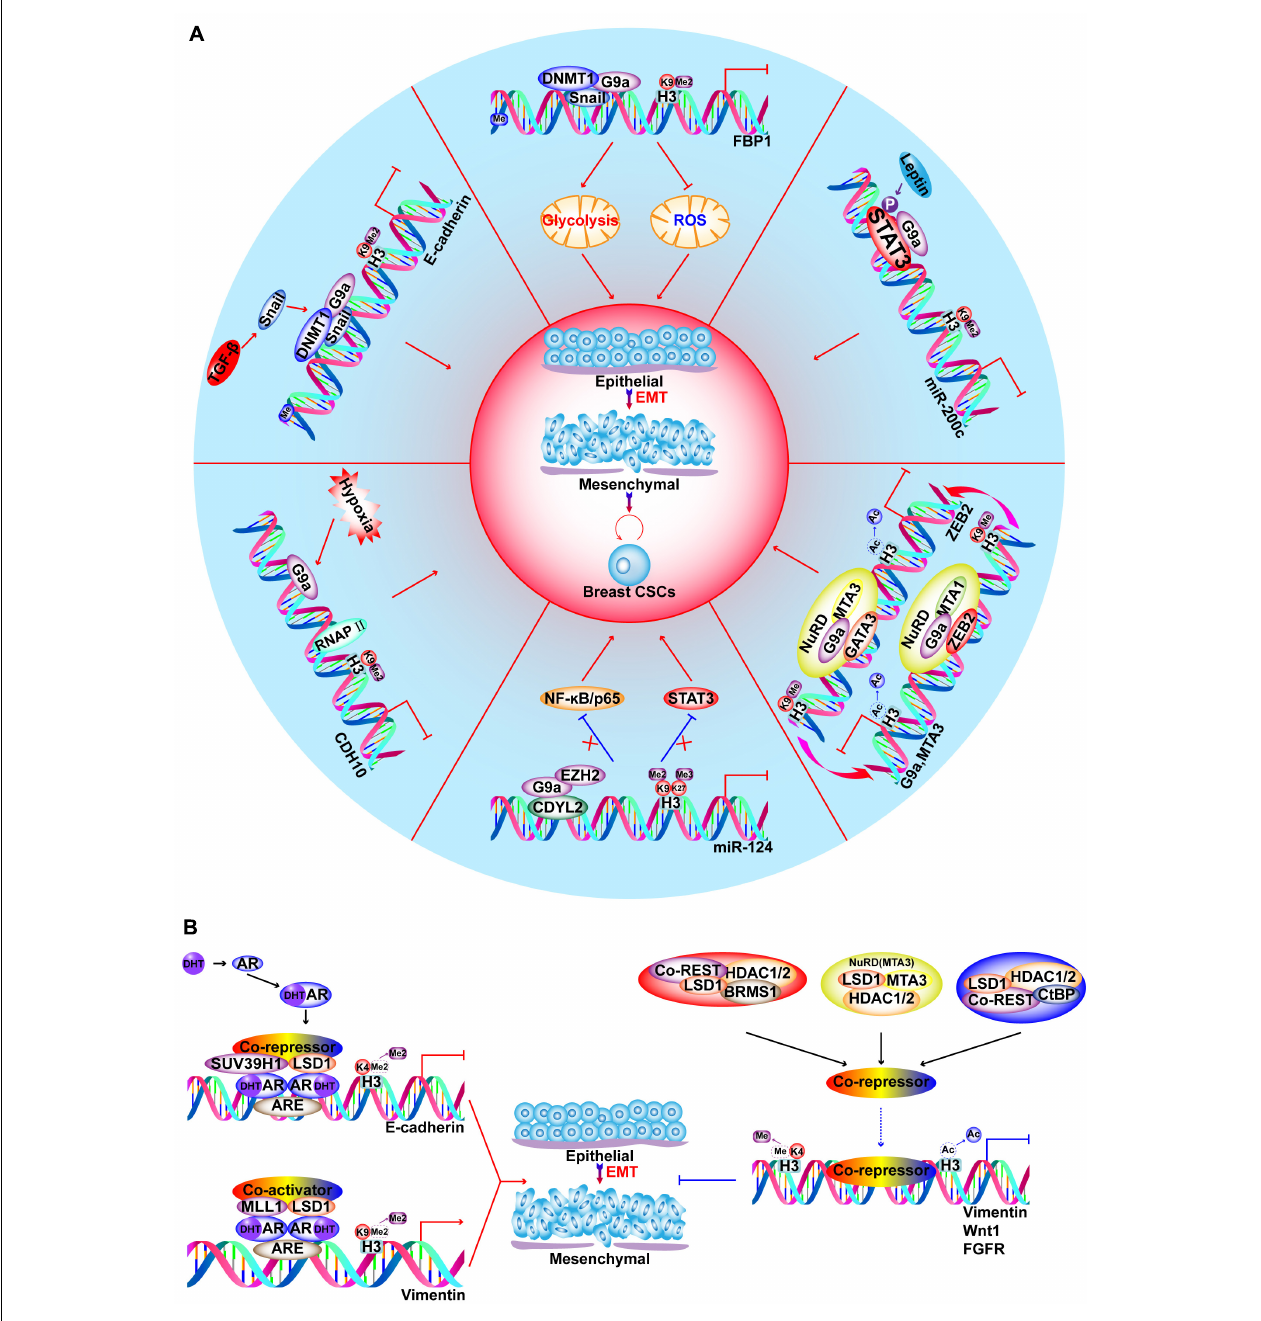
FIGURE 5 | Functions of G9a and LSD1 in regulating EMT and CSC-like characteristics of BC. (A) G9a promotes EMT and development of CSCs via different pathways, such as hypoxia response, metabolic reprogramming, obesity induced leptin and TGF β signaling stimulation. (B) Androgen receptor (AR) binds to AR-response elements (ARE) on target genes to recruit LSD1. On E-cadherin promoter, LSD1 demethylates H3K4 to repress gene expression; on vimentin promoter, LSD1 demethylates H3K9 to activate gene expression. LSD1 is a component of different corepressors complex, such as CoREST, CtBP, NuRD and SIN3A/HDAC. BRMS1-LSD1/CoREST/HDAC1/2 complexes cooperate in suppressing Vimentin ; SIX3/LSD1/NuRD (MTA3) complexes coorperate in repressing Wnt1 ; ZNF516-CtBP/LSD1/CoREST complexes cooperate in inhibiting EGFR oncogene to inhibit proliferation, invasion and EMT of breast cancer